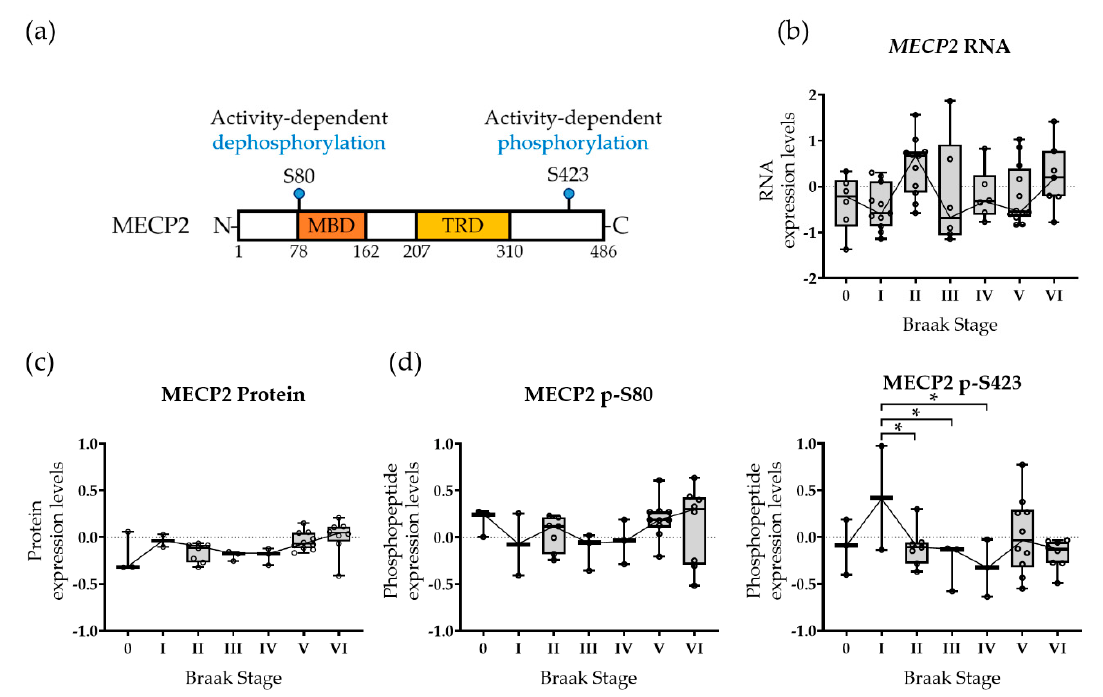
Figure 1. Methyl-CpG-binding protein 2 (MECP2) phosphorylation status is altered in a functionally relevant phosphorylation site with respect to Alzheimer’s disease (AD)-related neurofibrillary pathology in human brain. ( a ) Human MECP2 protein isoform 1 (MECP2A) with its functional domains: the methyl-CpG-binding domain (MBD) and the transcription repression domain (TRD). The positions of two functionally relevant phosphorylation sites, S80 and S423, are indicated in blue. ( b ) Expression of MECP2 transcript in relation to AD-related neurofibrillary pathology (Braak stage 0–VI) in human brain. Boxplots show median, 25th and 75th percentiles, whiskers show minimum and maximum of n = 59 brain samples. Number of samples in each Braak stage 0–VI group: n = 6, 11, 11, 6, 7, 12, and 7, respectively. One-way ANOVA, post-hoc LSD. ( c ) Expression of MECP2 protein in relation to AD-related neurofibrillary pathology in human brain. Boxplots show median, 25th and 75th percentiles, whiskers show minimum and maximum of n = 36 brain samples. Number of samples in each Braak stage 0–VI group: n = 3, 2, 7, 3, 3, 10, and 8, respectively. One-way ANOVA, post-hoc LSD. ( d ) Expression of MECP2 phospho-peptides in relation to AD-related neurofibrillary pathology in human brain. Boxplots show median, 25th and 75th percentiles, whiskers show minimum and maximum of n = 36 brain samples. Number of samples in each Braak stage 0–VI group: n = 3, 2, 7, 3, 3, 10, and 8, respectively. One-way ANOVA, post-hoc LSD; * p <